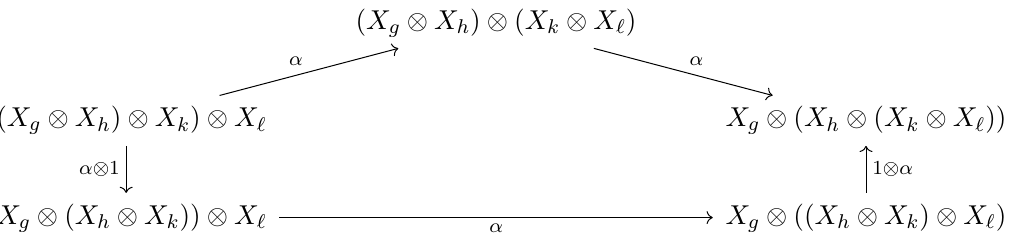
Figure 4 . Mathematically, the associator α is an element of Hom(( X g ⊗ X h ) ⊗ X k , X g ⊗ ( X h ⊗ X k )) that defines in what way the two tensor products are equal. Physically, given a theory with non- trivializable anomaly α ∈ H 3 ( G, U(1)) , two networks of symmetry defect lines can be different up to a U(1) phase.